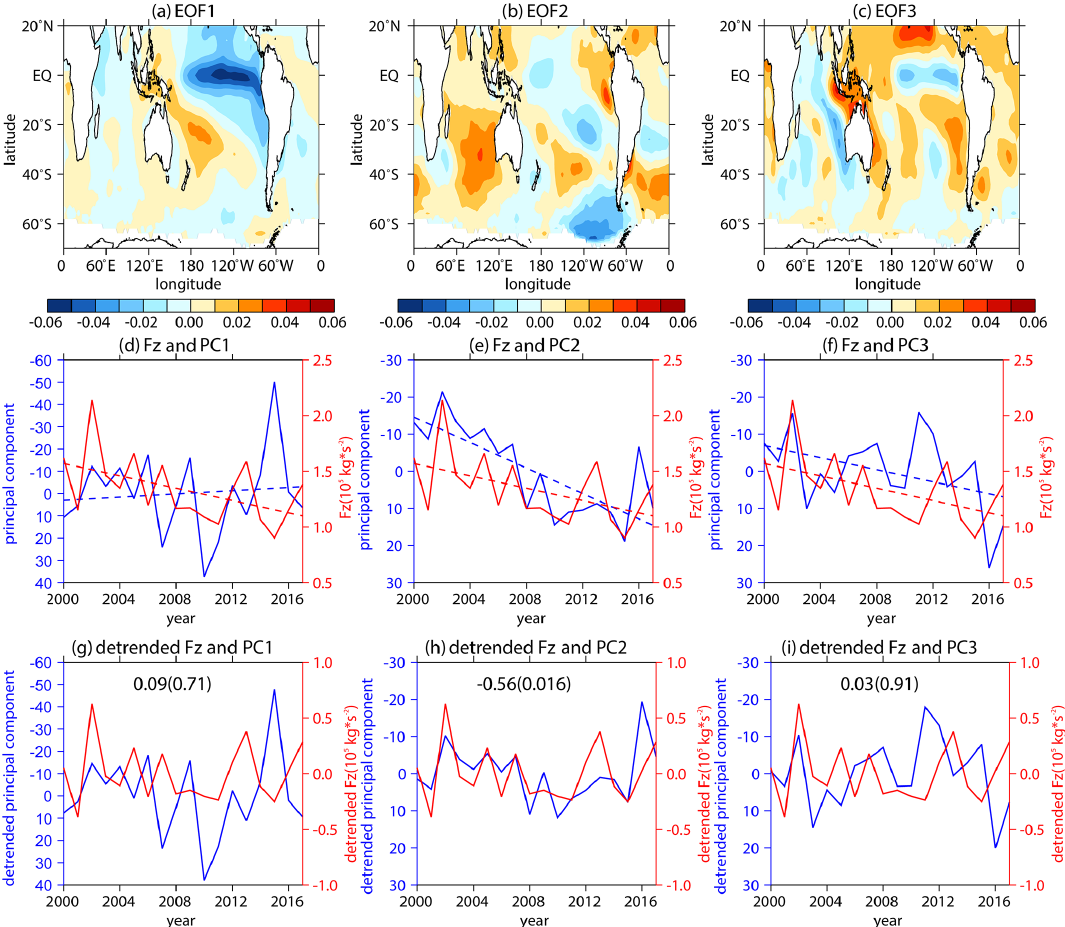
Figure 10. (a, b, c) The first three EOF patterns of SST in the SHtrop region. (d, e, f) The original time series of the first three principle components (PCs; blue solid lines correspond to left inverted y axes) and stratospheric vertical E–P flux (Fz; area weighted from 100 to 30hPa over 70–50 ◦ S; red solid lines correspond to right y axes) in September during 2000–2017. The blue and red dashed lines in panels (d) , (e) , and (f) represent the linear regressions of PC time series and Fz time series, respectively. The meaning of panels (g) , (h) , and (i) is the same as panels (d) , (e) , and (f) , correspondingly, except for the detrended time series. The numbers without (and in) parentheses in panels (g) , (h) , and (i) represent the correlation coefficients between the detrended PC time series and Fz time series and the corresponding p values calculated by the two-tailed t test,